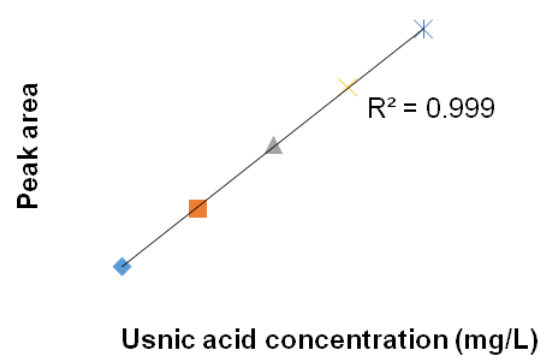
Figure 2. Calibration curve of usnicacid (Sigma–Aldrich) for HPLC